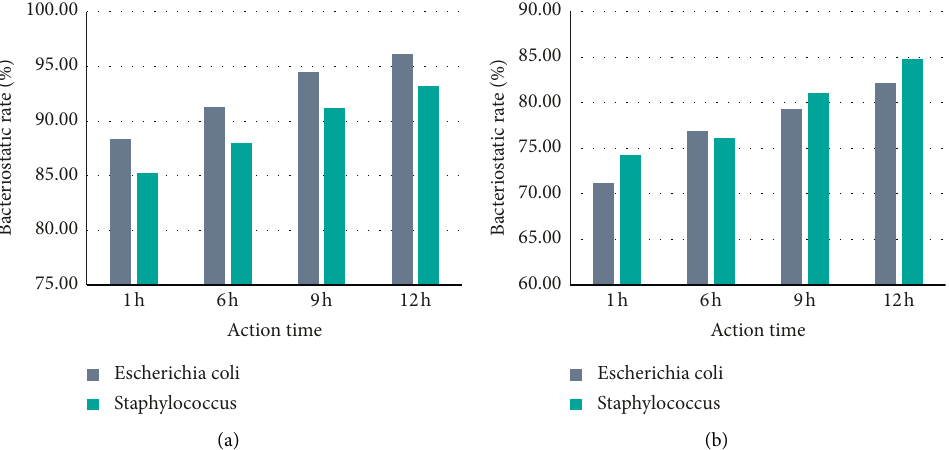
Figure 8: Bacteriostatic rate test. (a) The test result of the antibacterial rate of the experimental group. (b) The test result of the bacteriostatic rate of the control group.